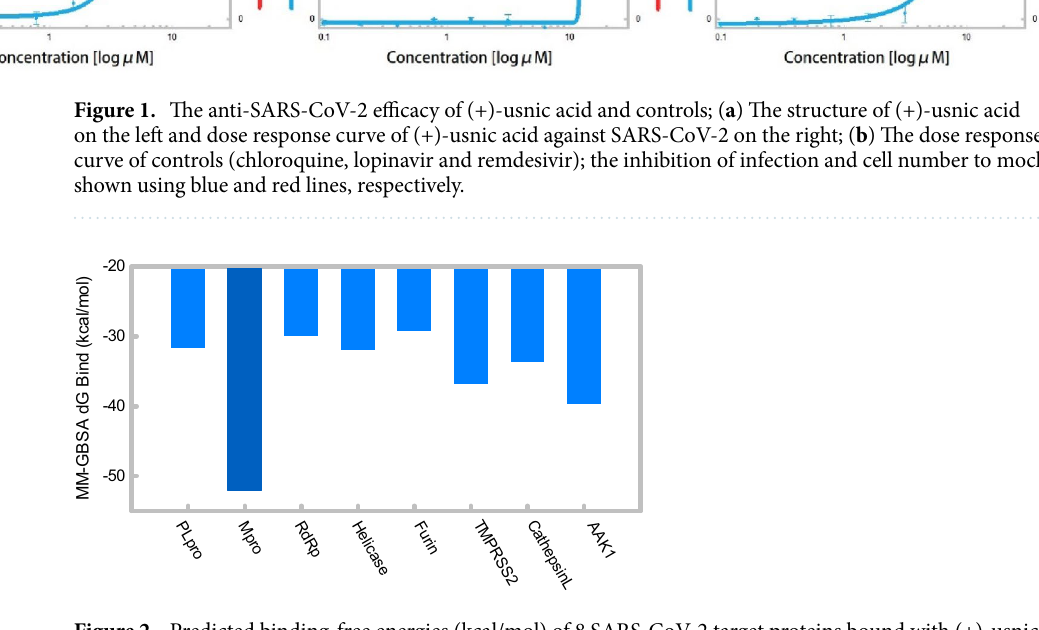
Figure 2. Predicted binding-free energies (kcal/mol) of 8 SARS-CoV-2 target proteins bound with (+)-usnic acid, calculated by Prime MM-GBSA.